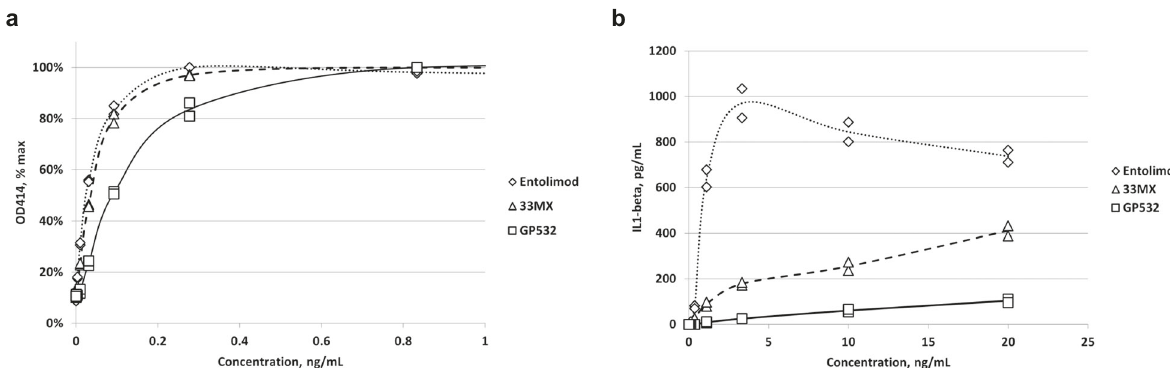
Fig. 5 Effects of C-terminal capping (in 33MX) and truncation (in GP532) on NF- κ B and in fl ammasome activation by TLR5 agonists. a NF- κ B- dependent induction of lacZ production (as indicated by OD 414 ) in HEK293-hTLR5::NF- κ B- lacZ reporter cells following incubation with different concentrations of entolimod, intermediate variant 33MX and GP532. b In fl ammasome activation by different concentrations of entolimod, 33MX and GP532 as indicated by IL-1 β production in a THP1-NLRC4 cell-based assay (measured by ELISA). Markers indicate individual values for duplicate samples and trend lines pass through mean